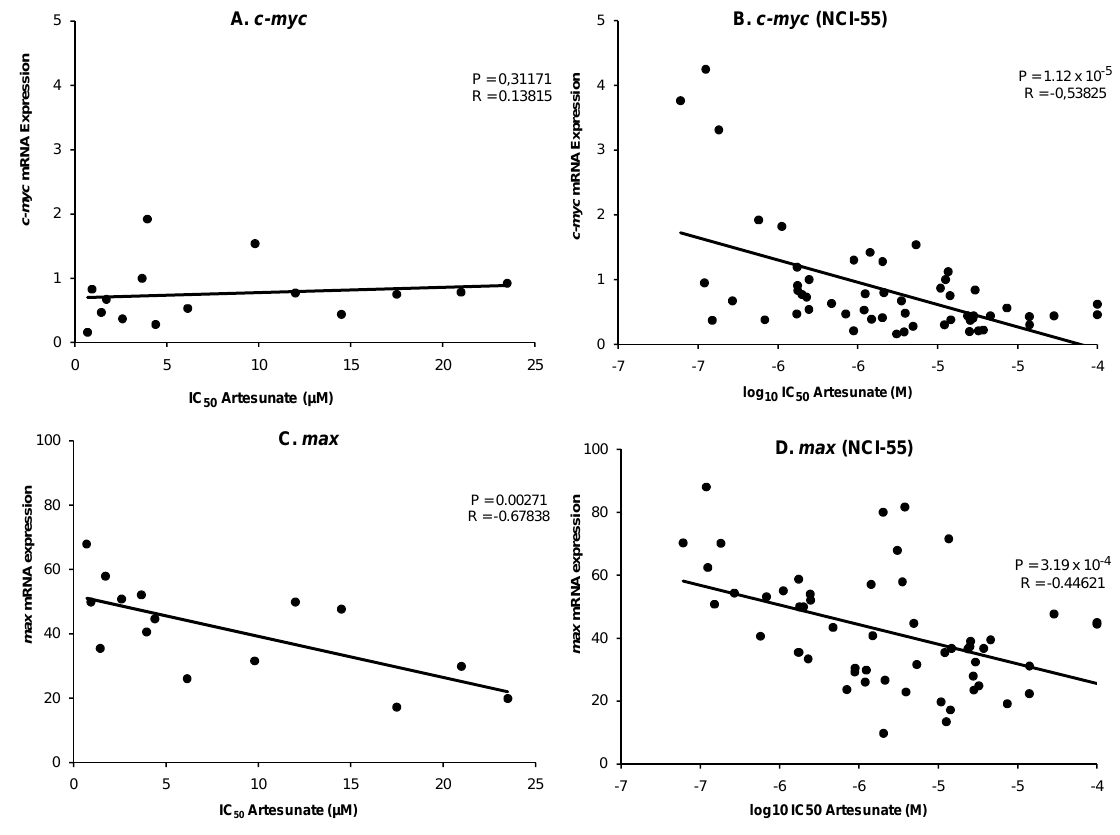
Figure 3. Linear regression of IC and Max (C) in our cell lines and linear regression of log expression of c-Myc (B) and Max (D) in the NCI cell line panel. Significance levels were calculated using Pearson’s correlation test.